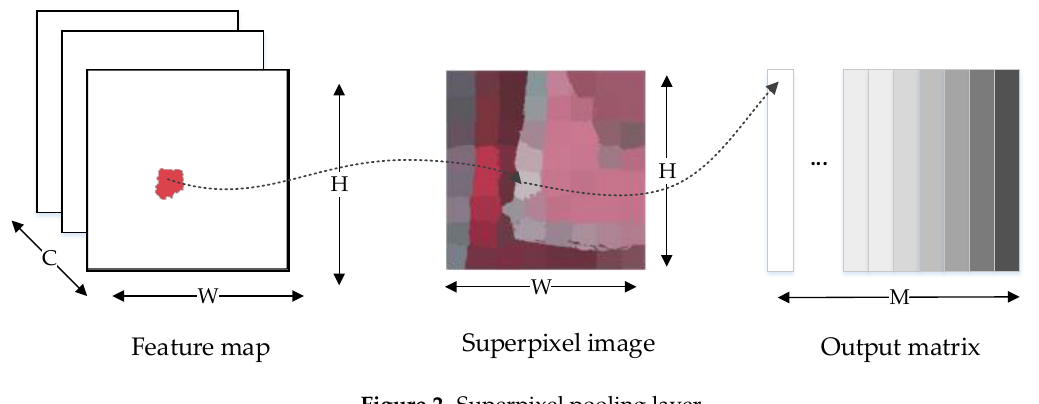
Figure 2. Superpixel pooling layer.